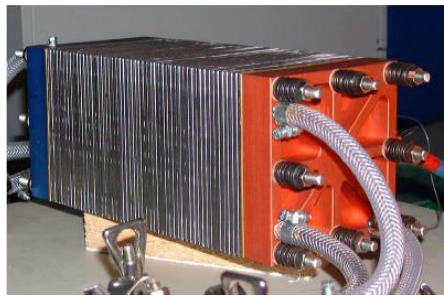
Figure 7. Stack of elementary cells (“stack”) produced by the German manufacturer UBzM, Ulm—Germany (GeePs laboratory). Energies 2020 , 13 , x FOR PEER REVIEW